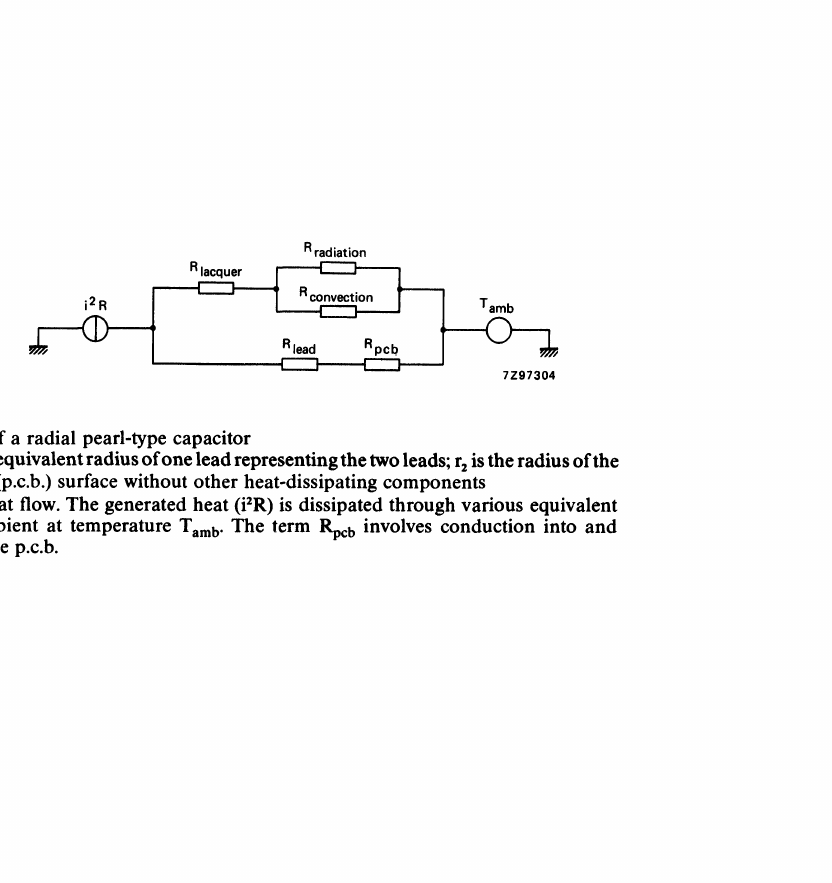
Rp b involves conduction into and b. The term